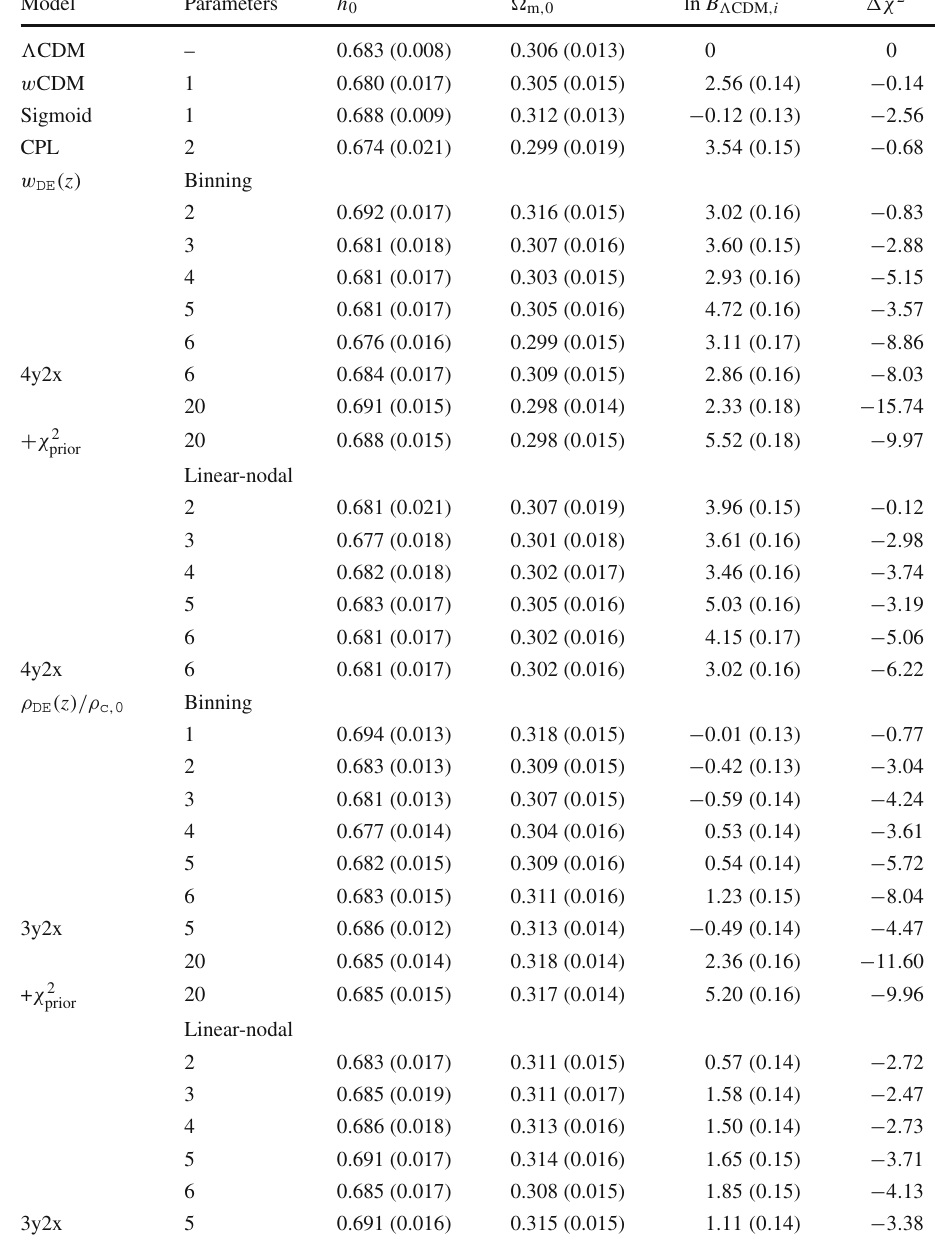
Table 3 Mean values, and standard deviations, for the cosmological